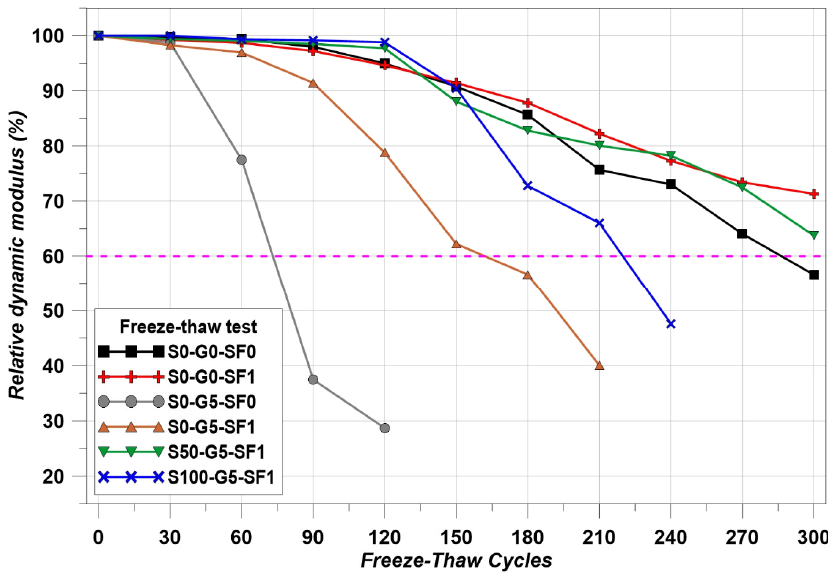
Figure 13. Freeze–thaw test results.